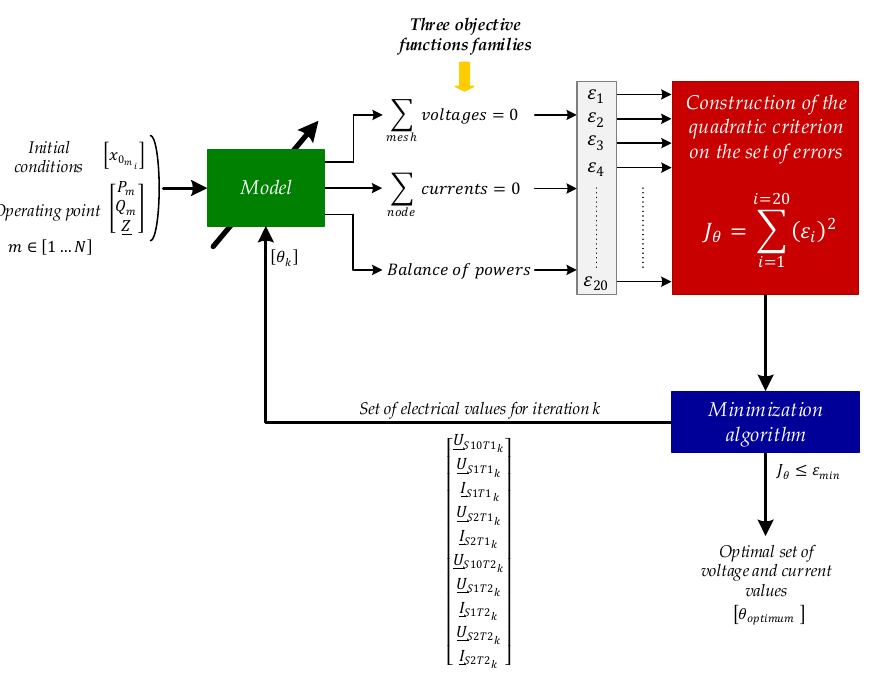
Figure 4. Principle for determining voltages and currents.